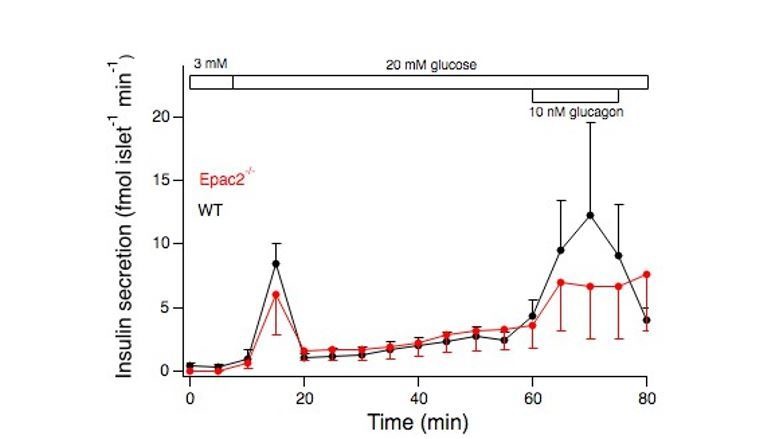
Means ± s.e.m. for blood for insulin from isolated islets stimulated by an elevation of the glucose concentration from 3 to 20 mM and addition of 10 nM glucagon.N=3 mice for each genotype.